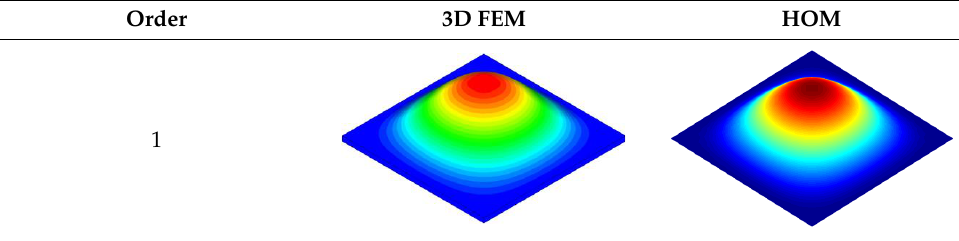
Table 2. First five-order mode shapes of the CCCC single-layer periodic plate. Order